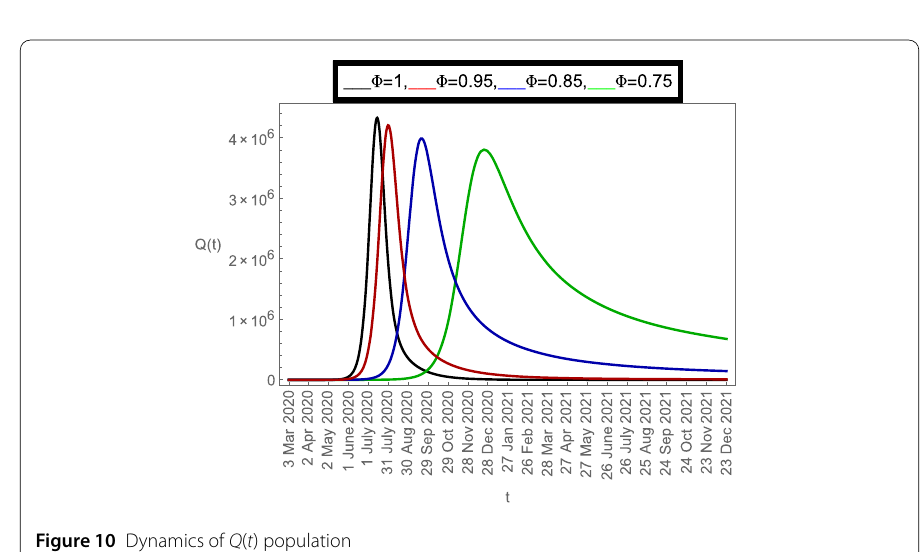
Figure 10 Dynamics of Q ( t ) population